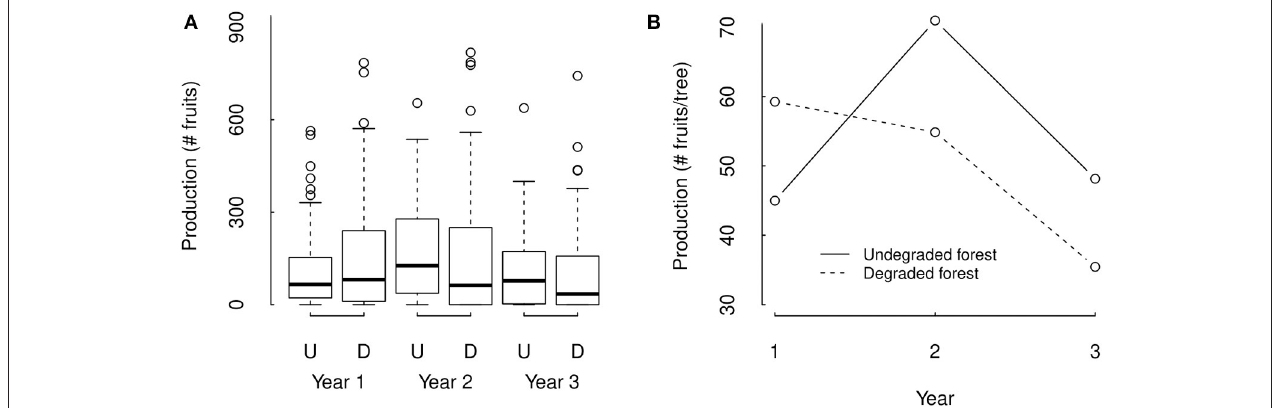
FIGURE 4 | Three years data (A) and statistical model estimations (B) of individual Brazil nut tree fruit production in undegraded (U) and degraded forest (D) in the Tambopata National Reserve and its buffer zone in Madre de Dios, Amazonian Peru. In panel (A) , boxes are the interquartile range (IQR), black lines in the middle of boxes are medians, whiskers are the extreme data point with 1.5 × IQR. The statistical model estimations in panel (B) represent estimations for an individual tree with average DBH and tree damage of trees present in our dataset, and were obtained with mixed effect all subset Poisson regression